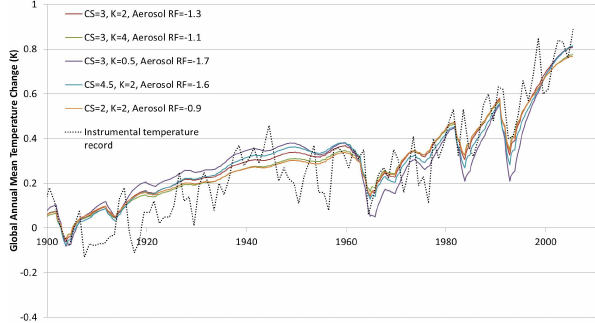
Table C3. GWP and IGTP values for SF 6 . K , the vertical heat dif- fusivity, is given in cm 2 s − 1 and CS, the climate sensitivity, is given in Kelvins per CO 2 equivalent